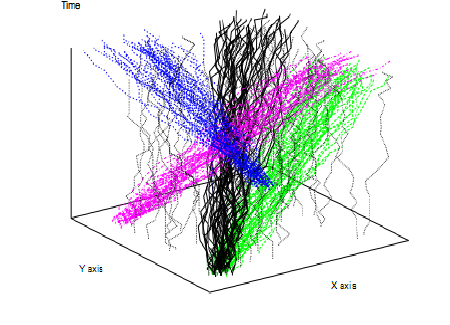
Fig.1. Illumination of trajectory